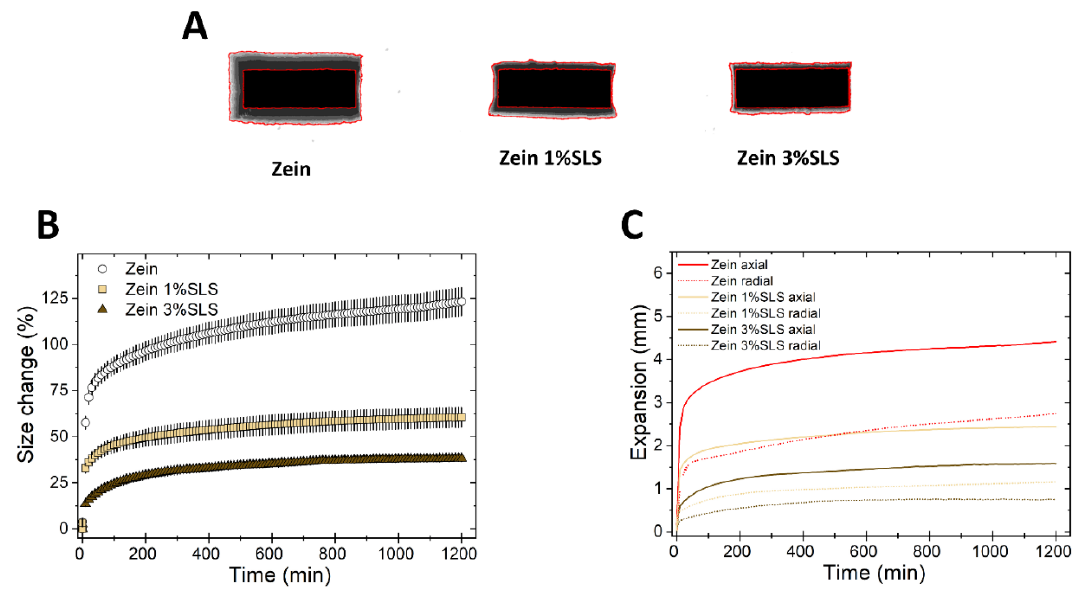
Figure 8. Swelling of tablets made of binary mixtures of zein and SLS (1% and 3% w / w ). ( A ) Sum of Z-stack of images. The two red lines are the outlines of the tablet at time 0 and at 20 h. ( B ) Swelling measured as the change of the projected area of tablets (mean ± SD, n = 3) as a function of time. ( C ) Axial and radial swelling of tablets (mean ± SD, n = 3) as a function of time.